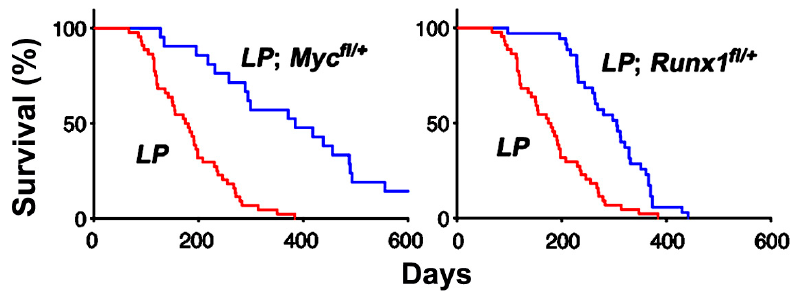
Figure 3. Lck -Cre; p53 fl/fl ( LP ) mice with heterozygous deletions of Myc ( LP ; Myc fl/+ mice) or Runx1 ( LP ; Runx1 fl/+ mice) show a significantly longer life span than the original LP mice. The data are modified from Date et al. (2022) [53].